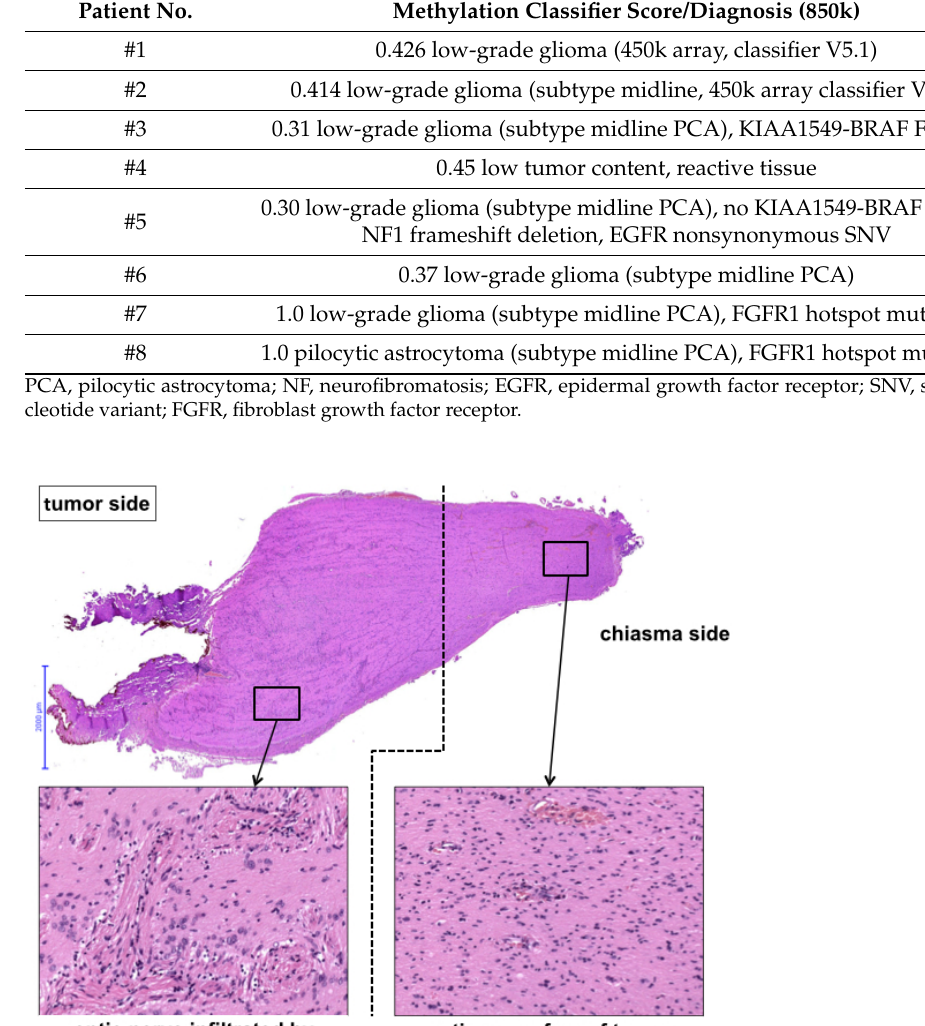
Table 2. Results of molecular genetic analysis. Patient No.